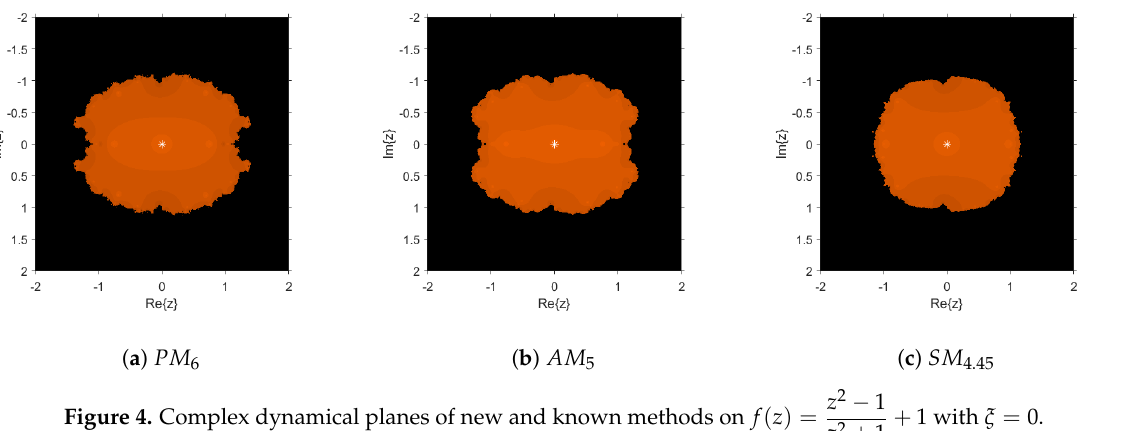
Figure 4. Complex dynamical planes of new and known methods on f ( z ) =